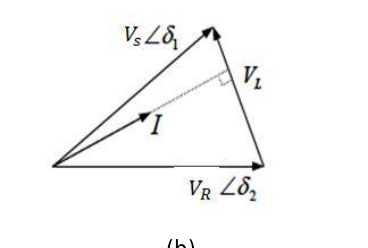
Figure 3. Power transmission system (a) simplified model (b) phase